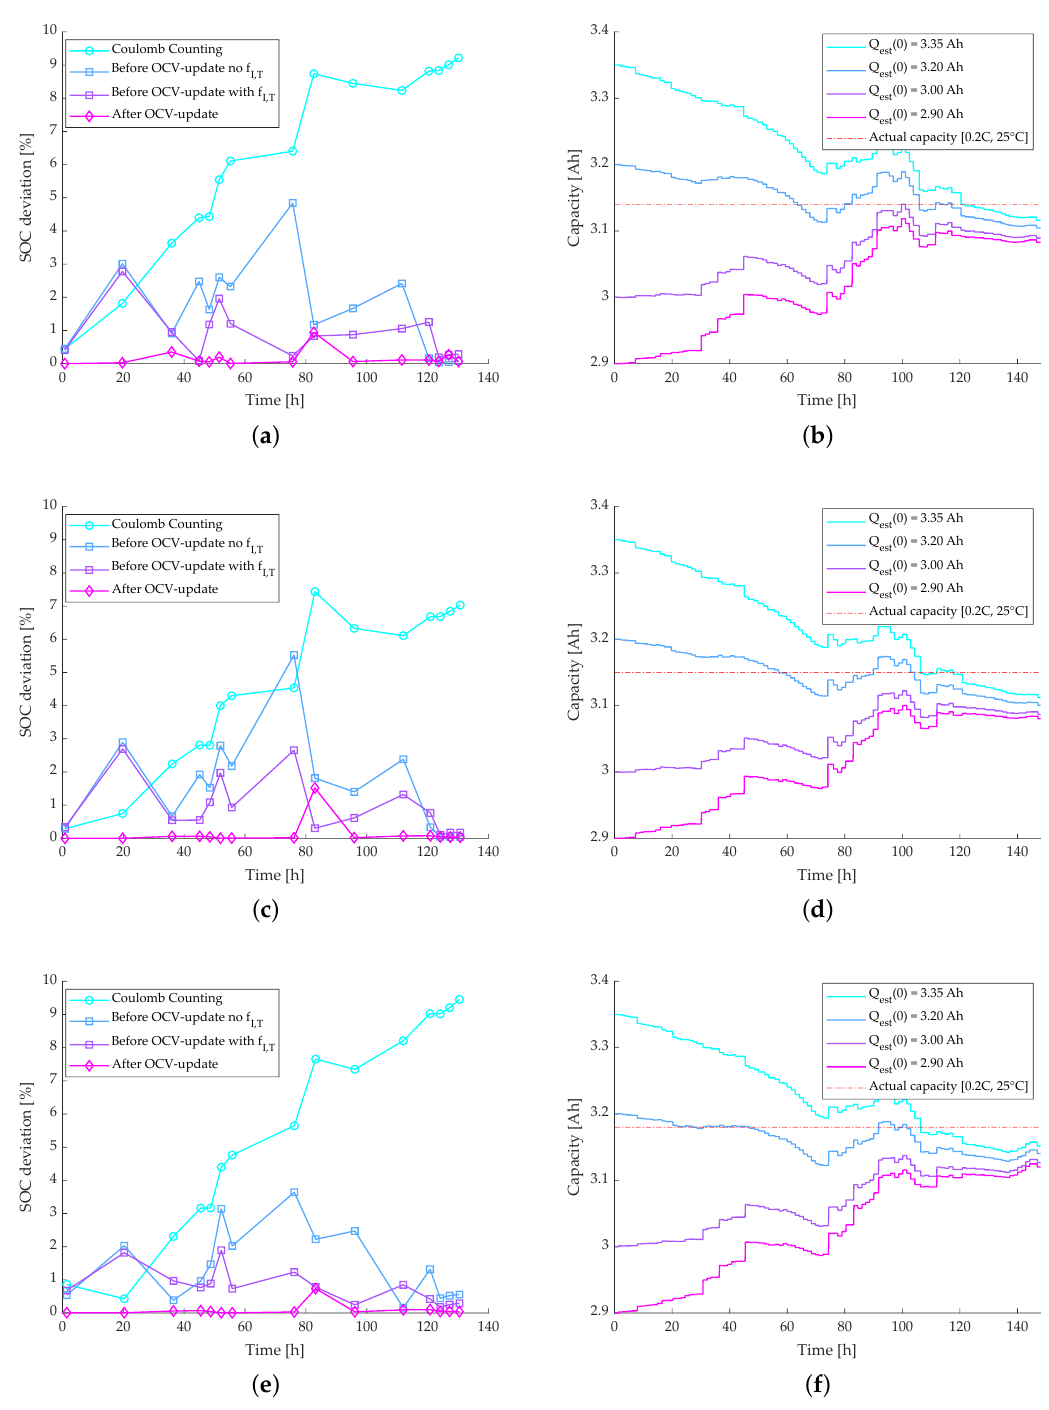
Figure 8. SOC deviation measured at fully charge state ( a ) SOC deviation (35 ◦ C aging), ( c ) SOC deviation (25 ◦ C aging) and ( e ) SOC deviation (15 ◦ C aging). Actual capacity estimation using the proposed method and different starting values ( b ) actual capacity estimation (35 ◦ C aging), ( d ) actual capacity estimation (25 ◦ C aging) and ( f ) actual capacity estimation (15 ◦ C